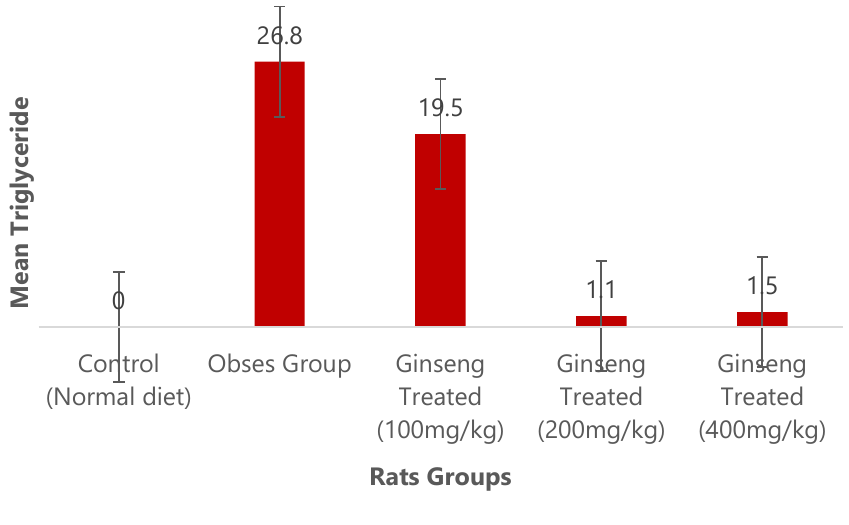
Figure 8: Comparison of mean Triglyceride in different groups.